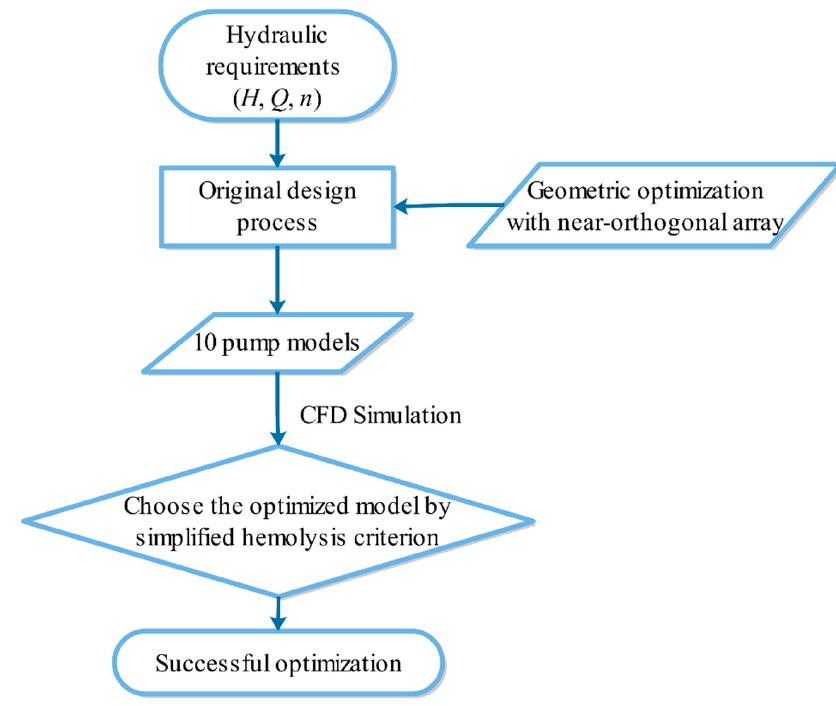
Figure 2. Flow chart of the optimization procedure.